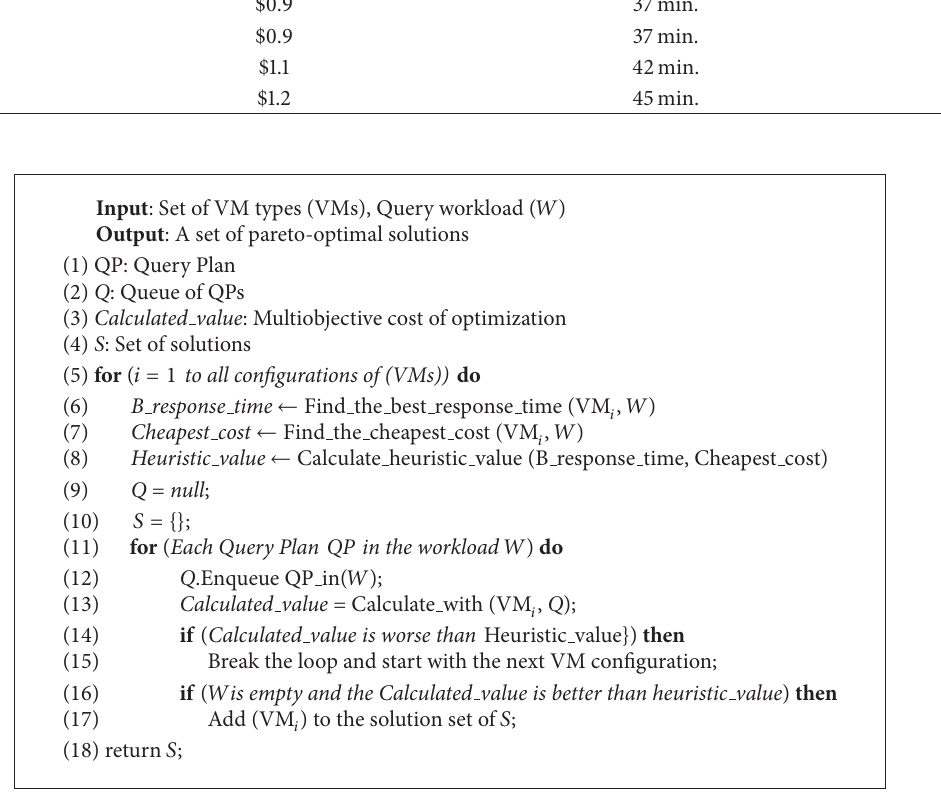
Algorithm 1: Multiobjective optimization of Cloud database configuration using